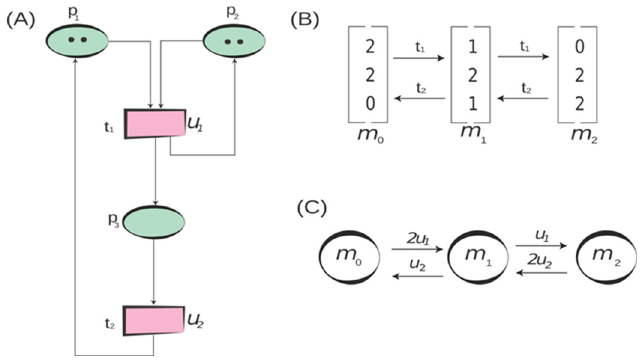
Fig 4. Example of a Stochastic Petri Net . (A) A SPN consists of a set of places { p 1 , p 2 , p 3 }, set of transitions { t 1 , t 2 }, rates μ 1 , μ 2 and an initial marking M 0 = (2, 2, 0). In case of this example t 1 is 2 enabled and t 2 is 0 enabled from the initial marking M 0 . (B) The reachability graph obtained from initial marking M 0 of the Petri Net . (C) The Markov Chain obtained from the reachability graph in (B). Every reachable marking of the SPN is associated with a state of the Markov Chain and a transition between states is labelled with the product of the enabling degree and